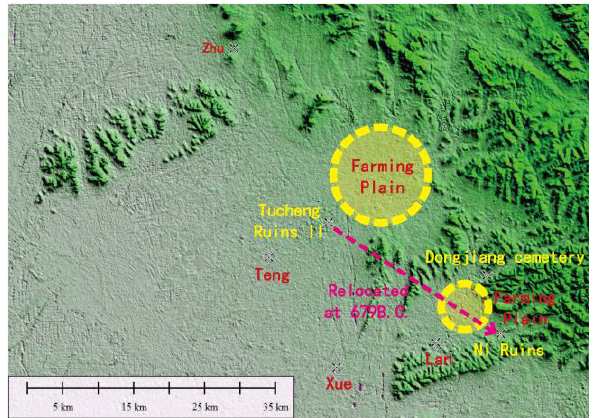
Figure 17. The situation analysis of Xiaozhu’s two capitals There was a cemetery at Dongjiang, not far from Ni ruins.